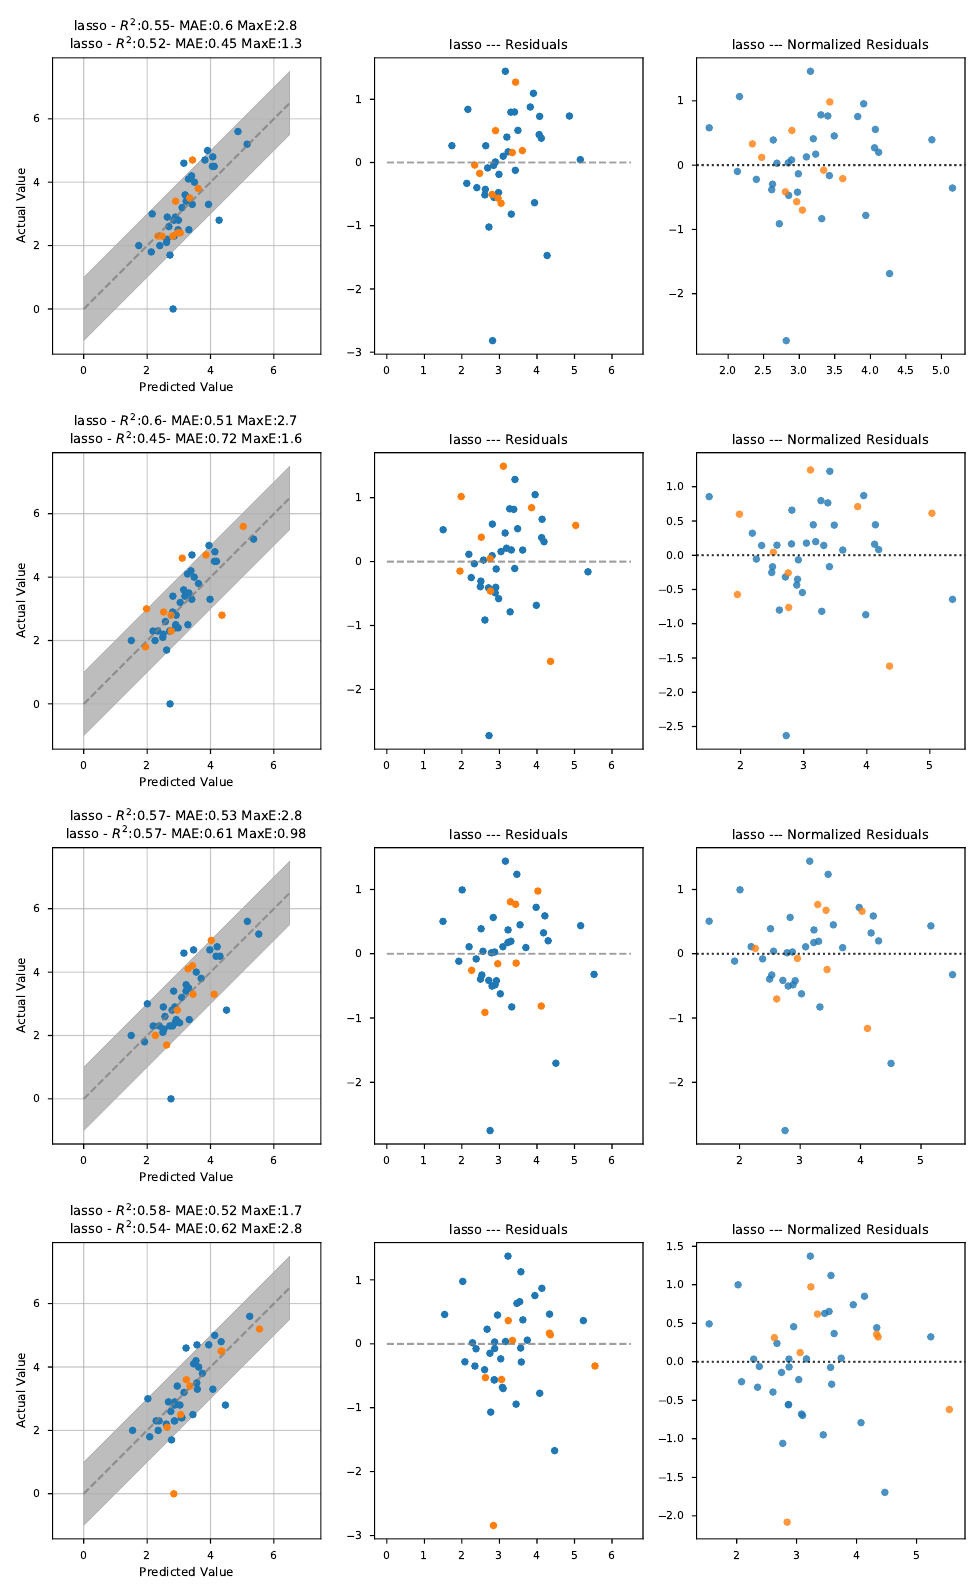
Figure 6. Visualization of the training and testing prediction results for the first four of the five iterations for the final models constructed using the S2F and S10M features. The gray band represents the zone of ± 1. Training points are blue and testing points are